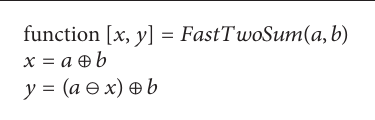
Algorithm 8: EFT of the sum of two floating point numbers (|𝑎| ≥ |𝑏|)